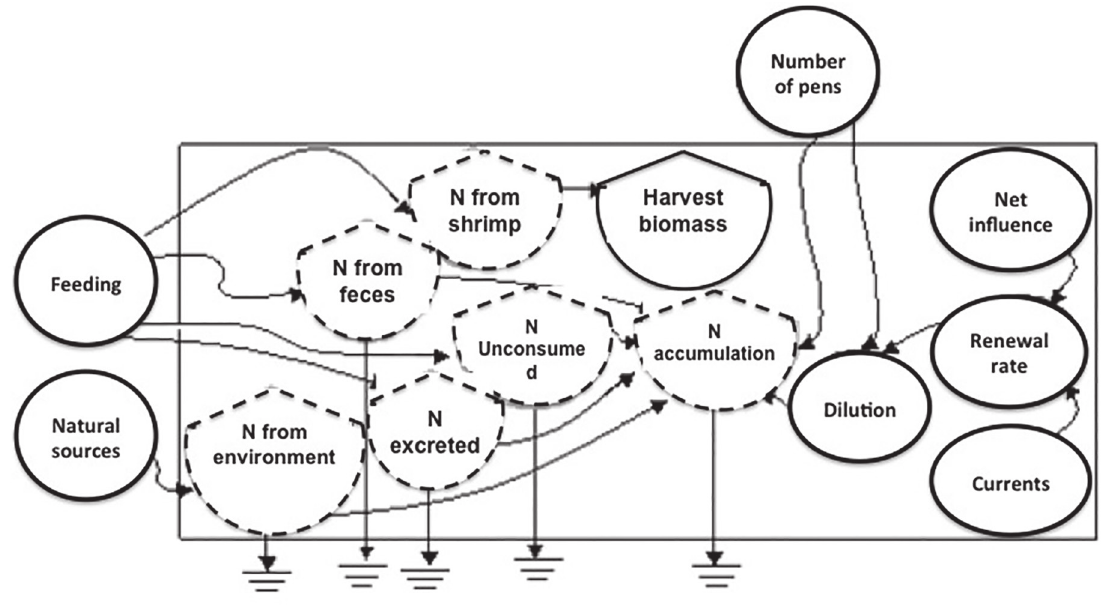
Figure 2 - Conceptual model of nitrogen input, transformation and removal from a semi-intensive shrimp pen culture